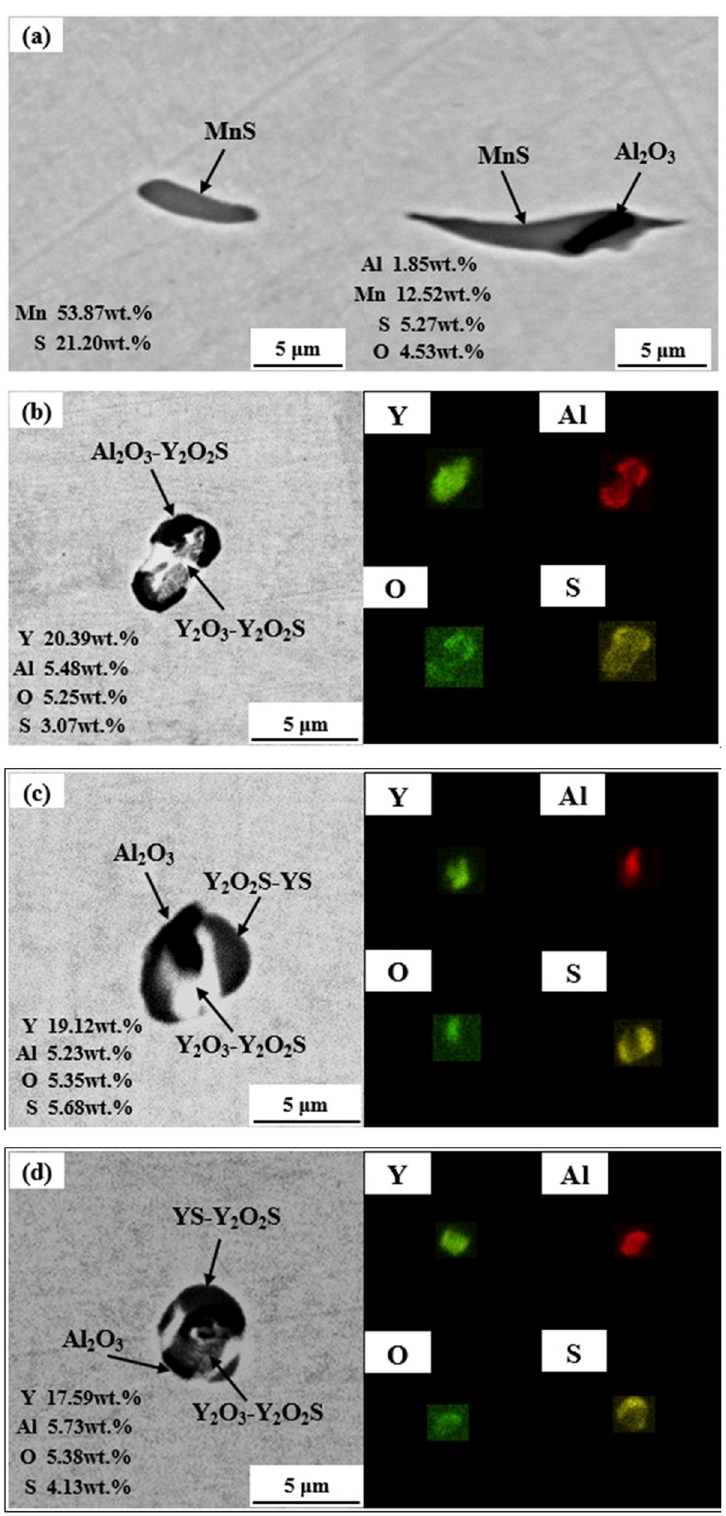
Figure 1: Morphology and type of inclusions formed in test steels. ( a ) No. 1 steel; ( b ) No. 2 steel; ( c ) No. 3 steel; and ( d ) No. 4